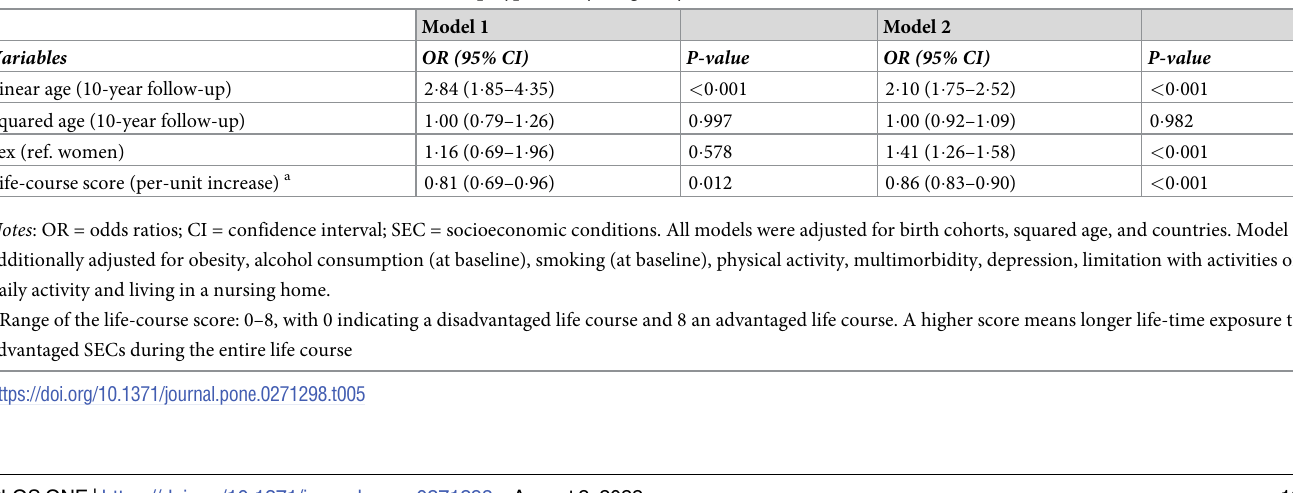
Table 5. Association of life-course SECs score with odds of polypharmacy at age 73 years. (N = 21,794).